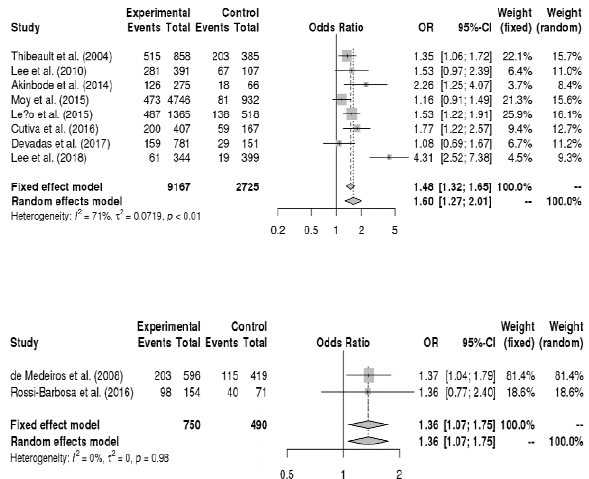
Figure 2. Forest plot about the relationship between vocal disorders and gender (up) and marital status (down).